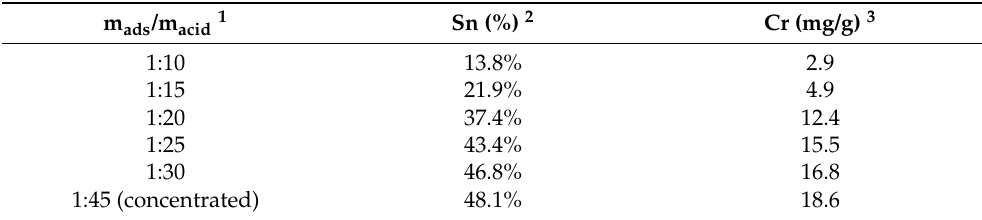
Table 5. Dissolved Sn and Cr in relation to solid-to-acid proportion used for dissolution (C ads : 10 g/L, acid: HCl, T: 25 ◦ C, t = 30 min).